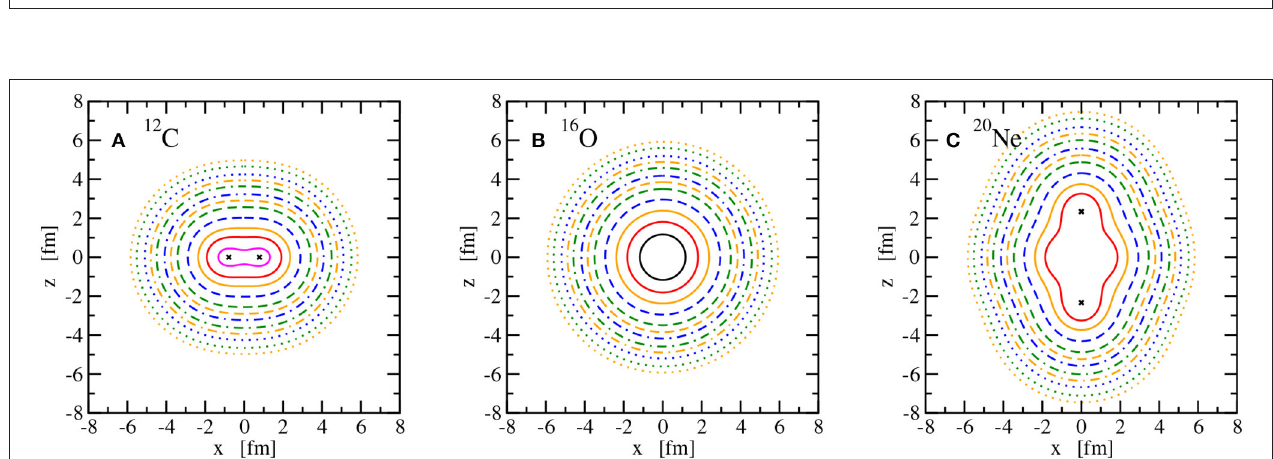
FIGURE 8 | Lines of constant intrinsic matter density ρ of the nuclei 4 He (A) and 8 Be (B) . Points of maximum density are indicated with a